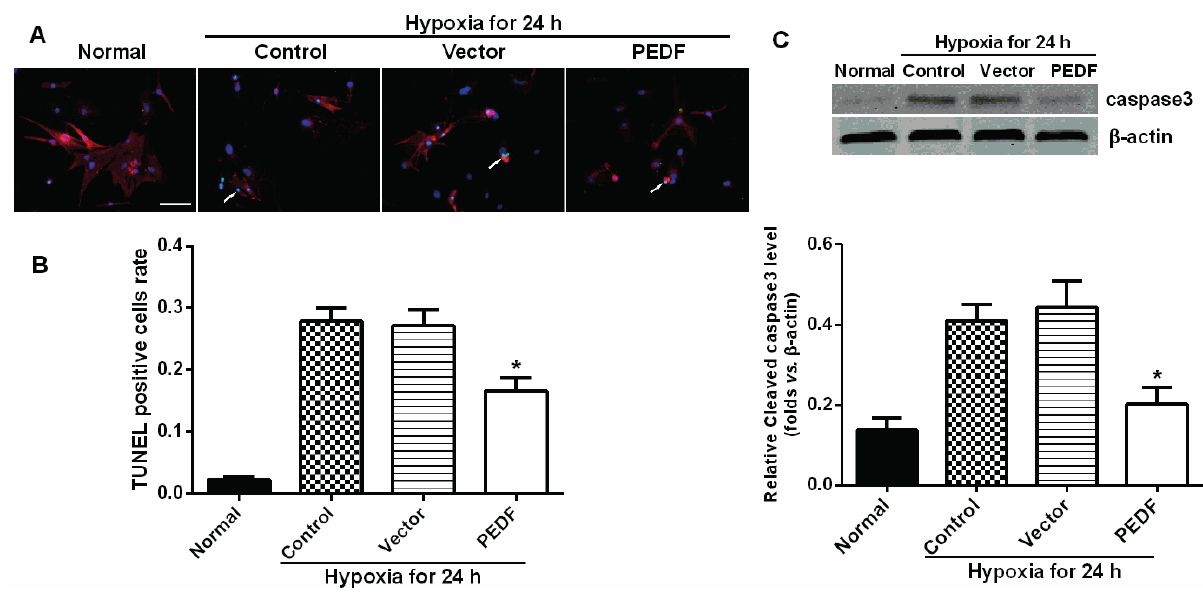
Figure 3. PEDF protected against hypoxia-induced cell death. ( A ) TUNEL (green) and α -sa (red) staining were performed for each group. Nuclei were stained with Hoechst (blue). Immunofluorescent images showed that TUNEL-positive cells (indicated by the arrows) were increased after hypoxia. Under condition of hypoxia, PEDF exhibited anti-apoptotic effects (scale bar = 20 μ m); ( B ) Statistical analyses from immunofluorescent images; ( C ) Western blot determination for protein expression of cleaved caspases-3. The